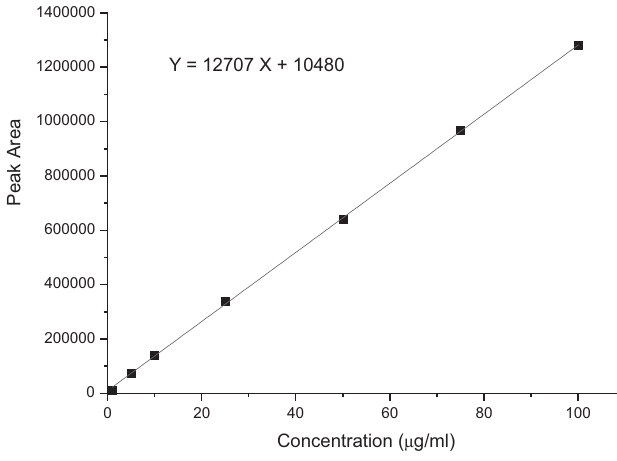
FIGURE 3 – Calibration curve for ISDN from the HPLC